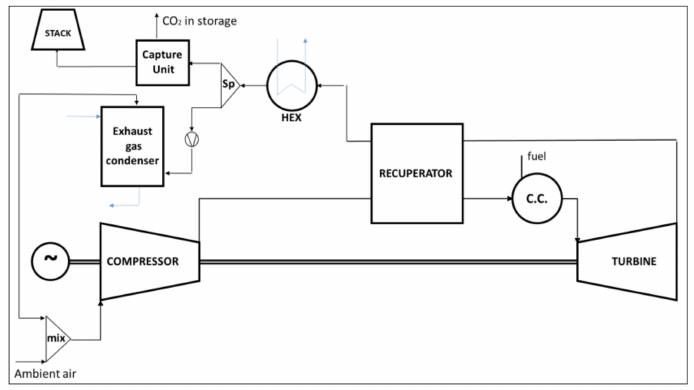
Figure 9. An EGR micro gas turbine with CO 2 capture